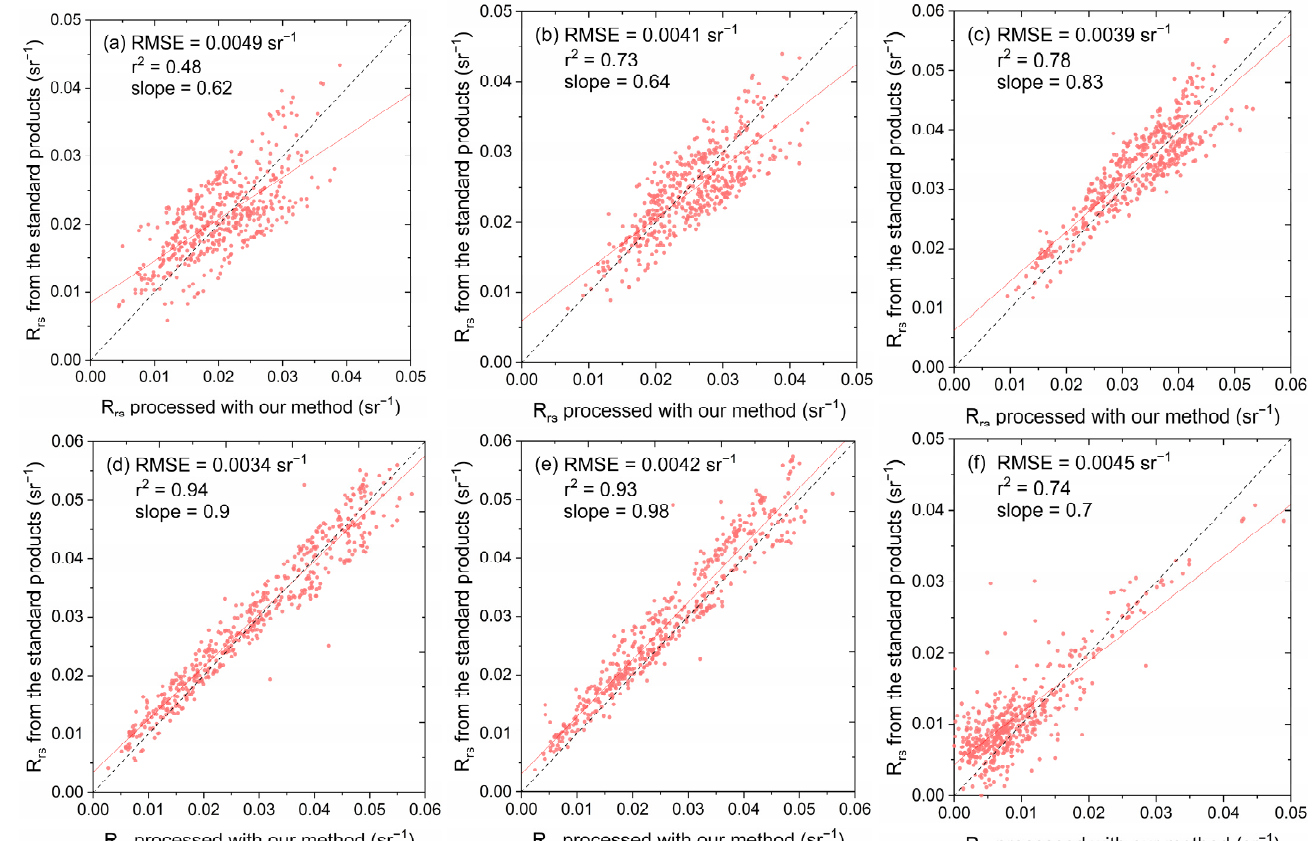
Figure 6. Scatterplots of R rs processed with our method versus the R rs obtained from standard products: ( a ) Band 1 ( λ = 443 nm), ( b ) Band 2 ( λ = 492 nm), ( c ) Band 3 ( λ = 560 nm), ( d ) Band 4 ( λ = 665 nm), ( e ) Band 5 ( λ = 704 nm) and ( f ) Band 8A ( λ = 865 nm).